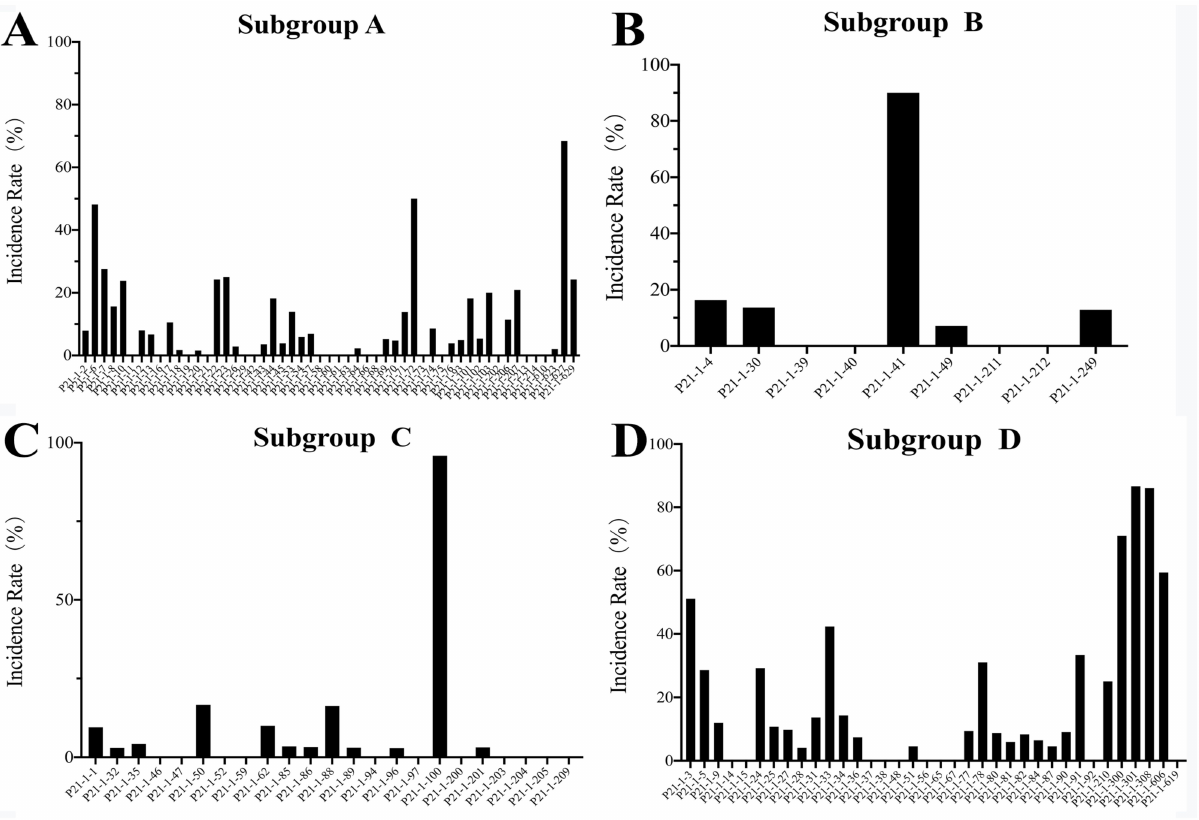
Figure 3. Statistics of incidence rates of different varieties in four subgroups. ( A ): The incidence rates of clubroot disease of different varieties in subgroup A; ( B ): The incidence rates of clubroot disease of different varieties in subgroup B; ( C ): The incidence rates of clubroot disease of different varieties in subgroup C; ( D ): The incidence rates of clubroot disease of different varieties in subgroup D.